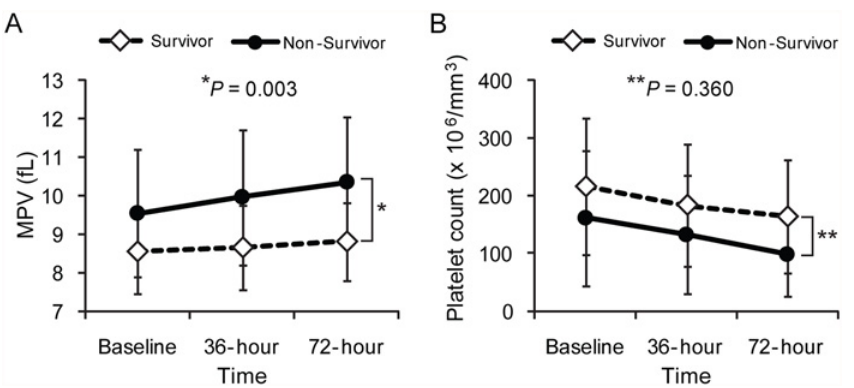
Fig 2. Comparison of trends in the platelet indices between survivors and non-survivors during the first 72 hours after emergency department admission. (A) The rate of mean platelet volume increase over the first 72 hours in non-survivors was significantly different from that observed in survivors ( P = 0.003). (B) The rate of platelet count decline over the first 72 hours was comparable between the 2 groups ( P = 0.360).